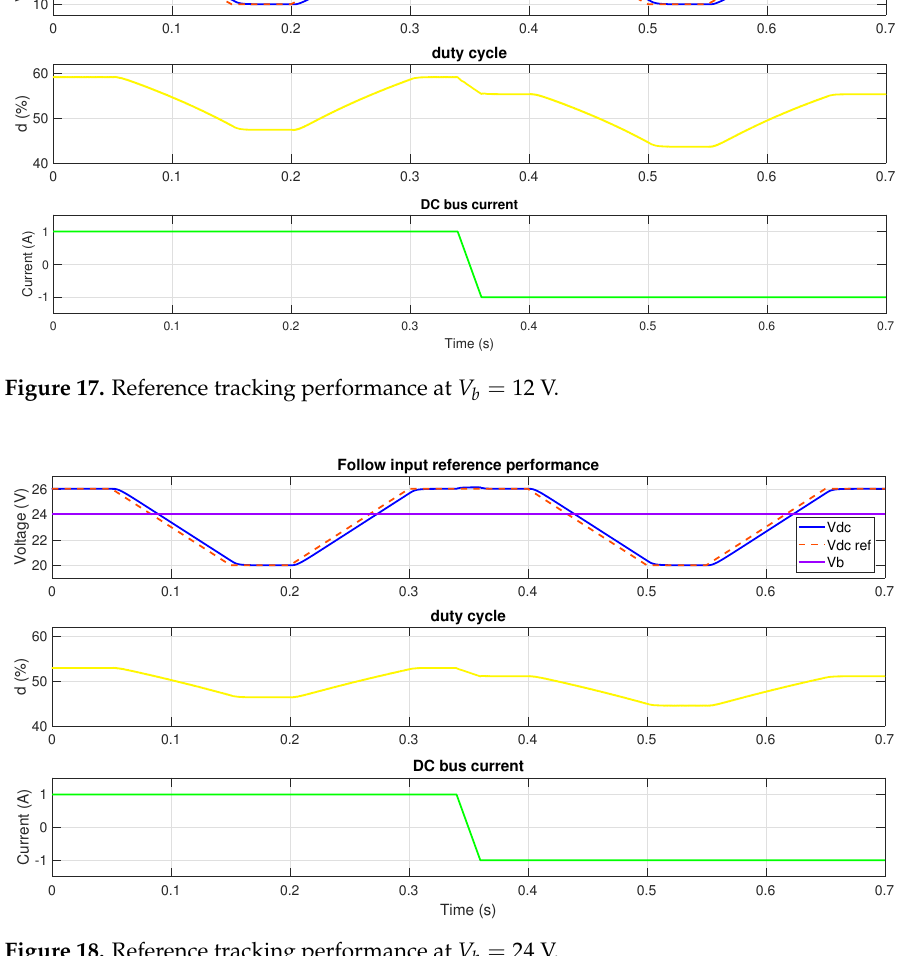
Figure 18. Reference tracking performance at V b = 24